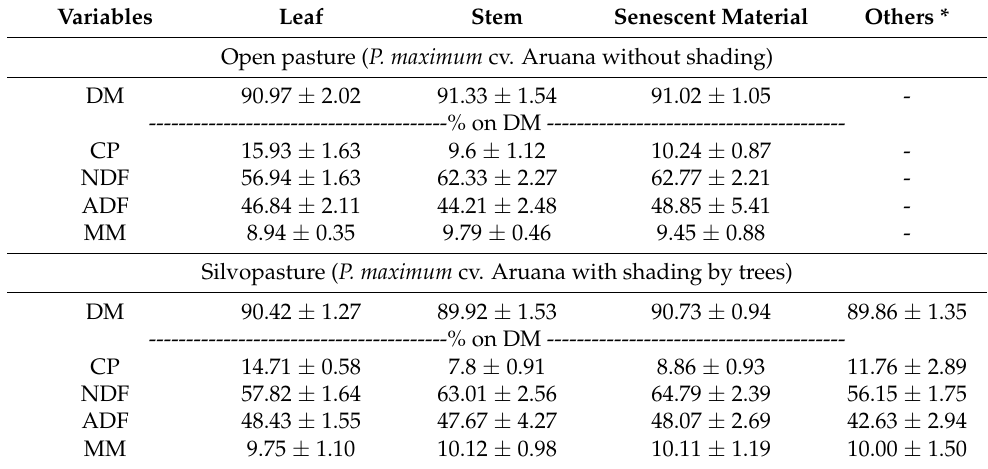
Table 1. Chemical compounds (percentage ± SD) of pasture components in both productive systems: DM = dry matter; CP = crude protein; NDF = neutral detergent fiber; ADF = acid detergent fiber; MM = mineral matter. Variables Leaf Stem Senescent Material Others * Open pasture ( P. maximum cv. Aruana without shading)